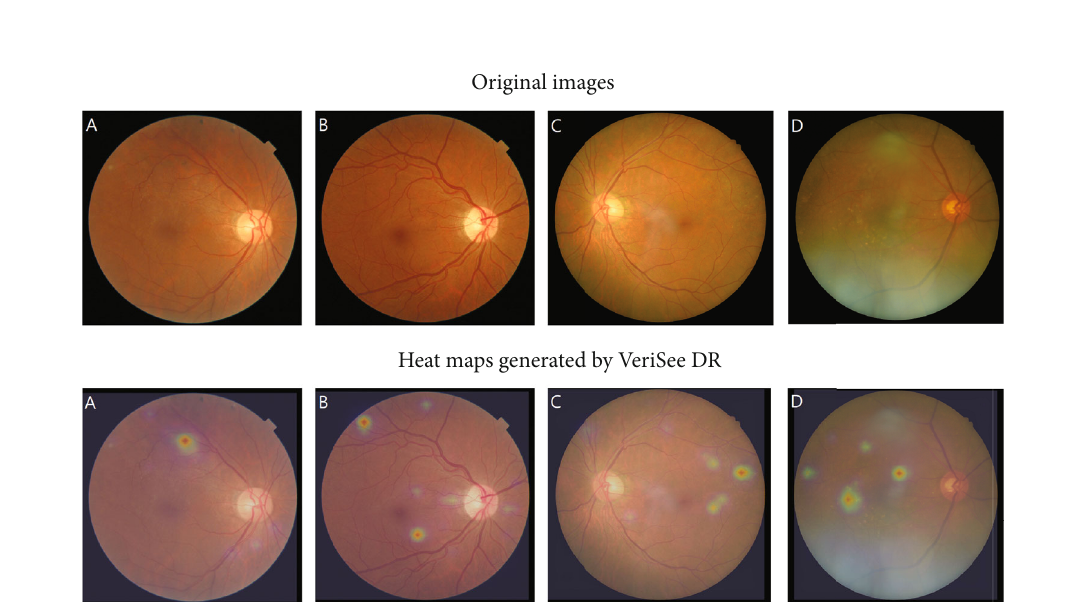
Figure 1: Original images and the heat maps generated by VeriSee DR of 4 cases of proliferative diabetic retinopathy (PDR) or severe nonproliferative diabetic retinopathy (NPDR) that were diagnosed as nonreferable DR by VeriSee DR. (a) A case of psedumed PDR with only suspected laser scars but no microaneurysm or hemorrhage, (b) a case of presumed PDR with atypical neovascularization of the disc and few microaneurysms, (c) a case of branch retinal vein occlusion which was diagnosed as severe NPDR, and (d) a case of age- related macular degeneration and old retinal vein occlusion which was diagnosed as severe